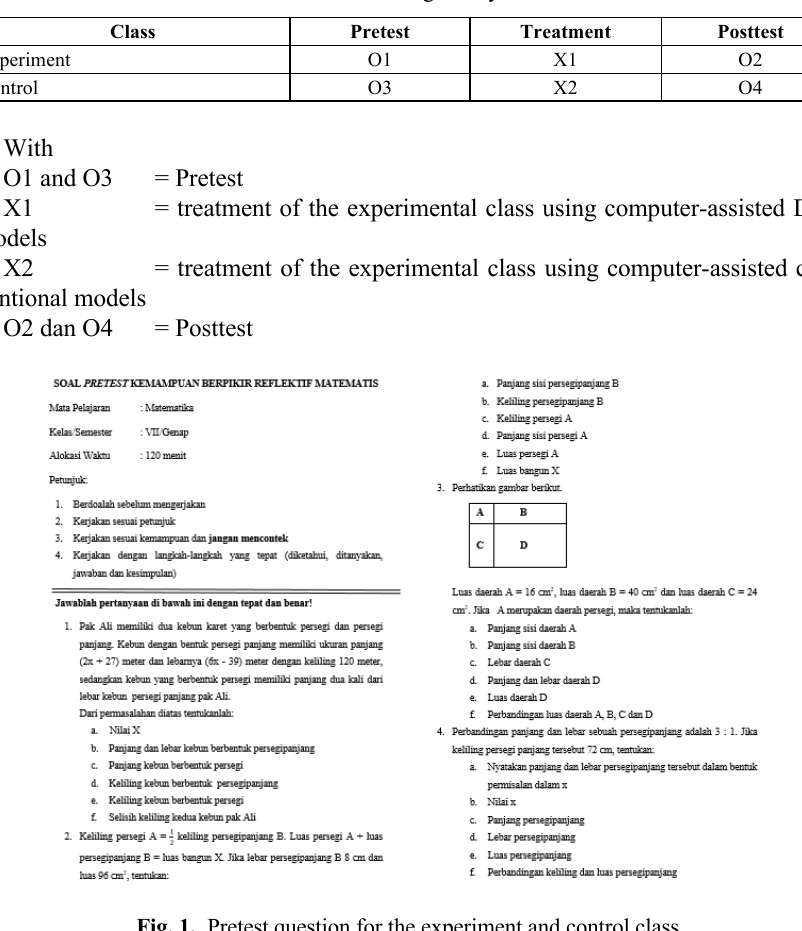
Fig. 1. Pretest question for the experiment and control